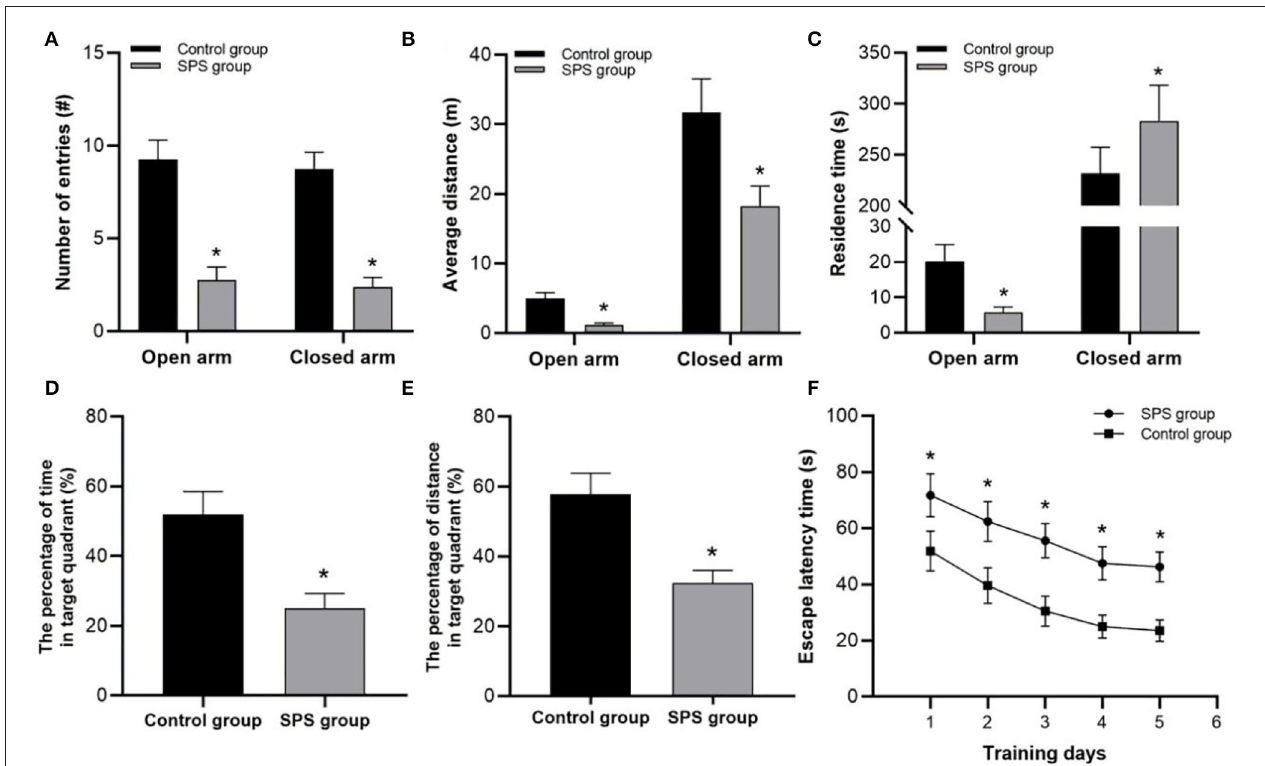
FIGURE 2 | Behavioral test results. (A) Number of entries into open and closed arms. (B) Average distance traveled in open and closed arms. (C) Residence time in open and closed arms. (D) Percentage of swimming time in target quadrant. (E) Percentage of swimming distance in target quadrant. (F) ELT in 5 test days. * P < 0.05 vs. control group.